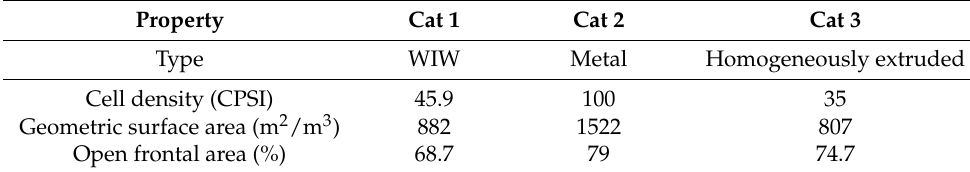
Table 2. Properties of the catalysts.